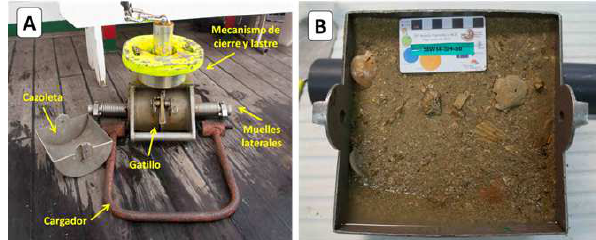
Figure 15. A) Shipek dredge with the different parts; B) surface